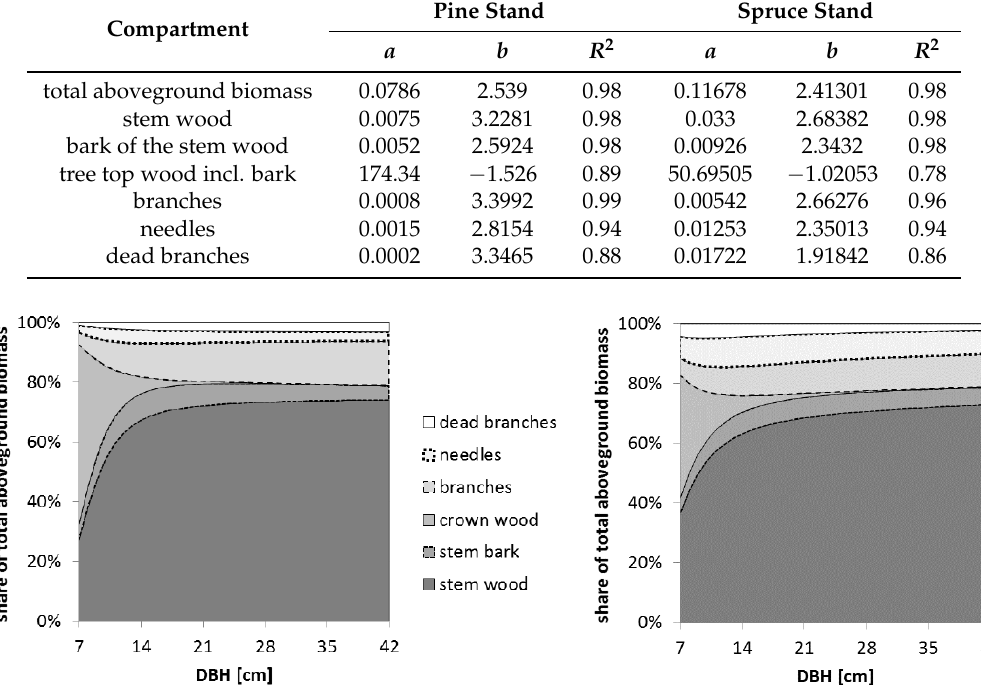
Figure 3. Share of aboveground biomass compartments of the examined Scots pine ( left ) and Norway spruce ( right ) stand at a DBH ‐ range of 7 to 42 cm.